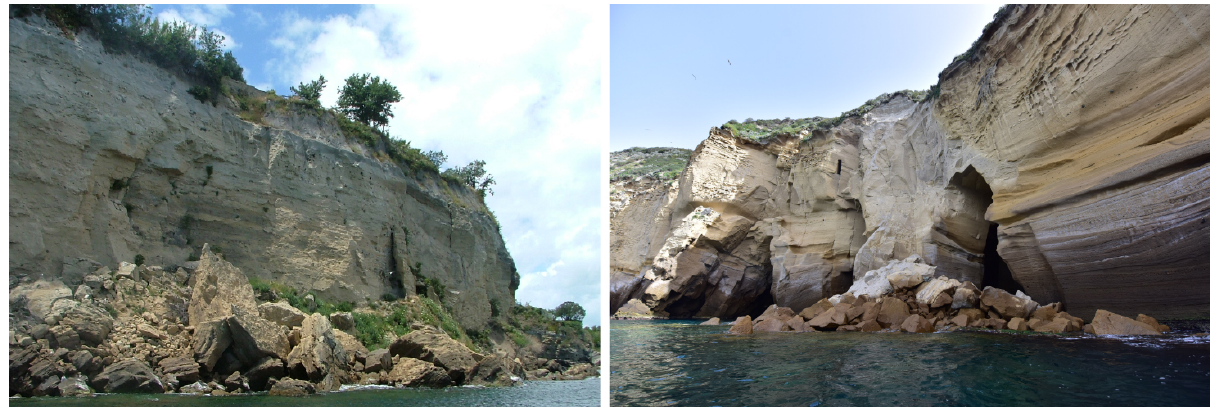
Figure 5. Examples of rock fall affecting the Campi Flegrei coastal cliffs: Punta Miseno (2015) on the left and Trentaremi–Capo Posillipo (2017) on the right (both sites are indicated in Fig. 1) (image credits: Alessandro Fedele, INGV).